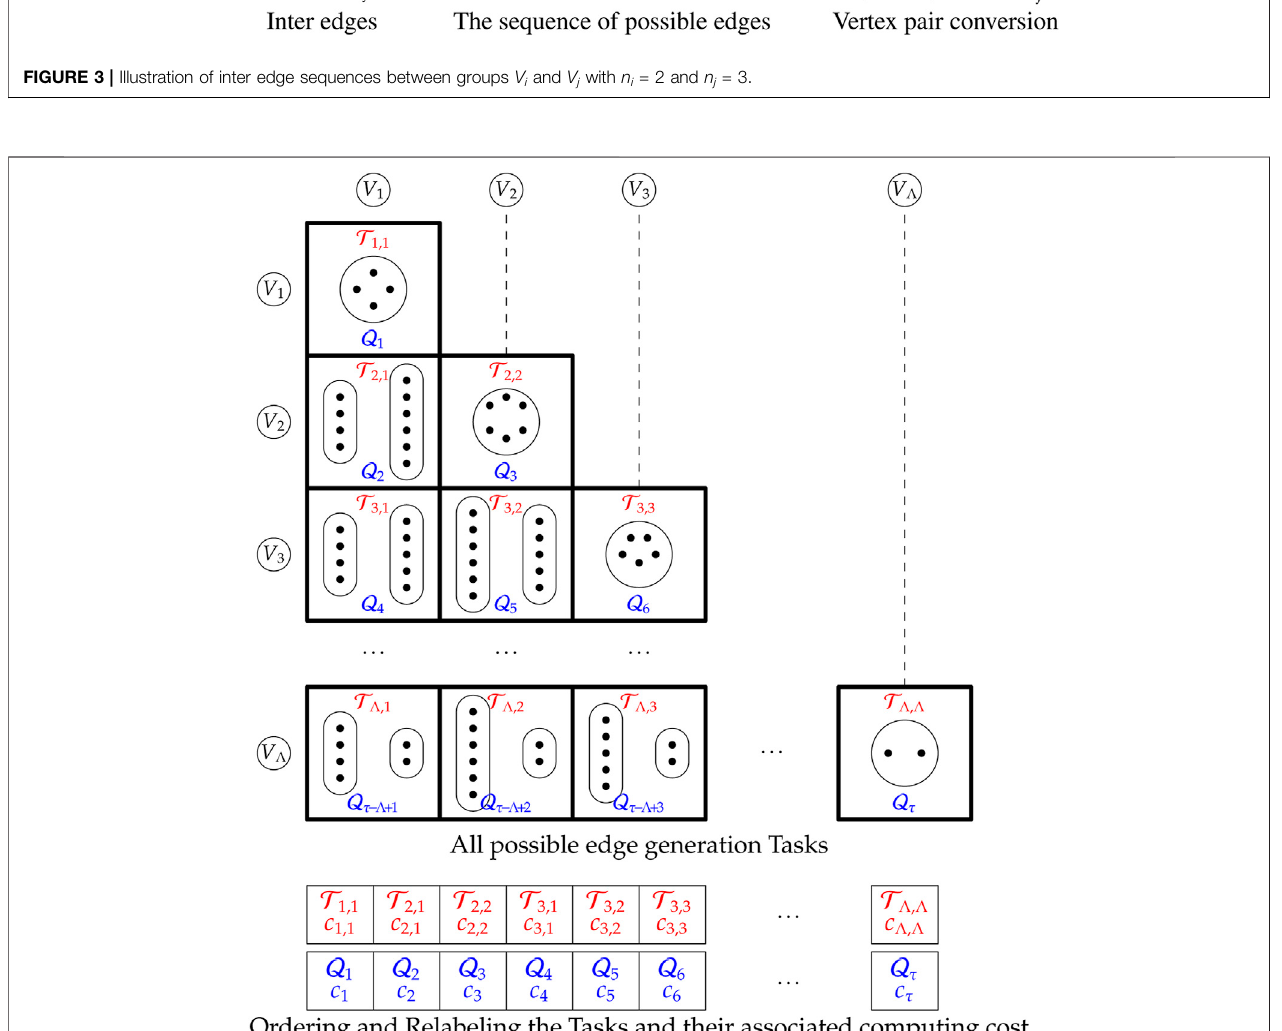
FIGURE 4 | Listing of edge generation tasks T i , j and relabeling to Q x .